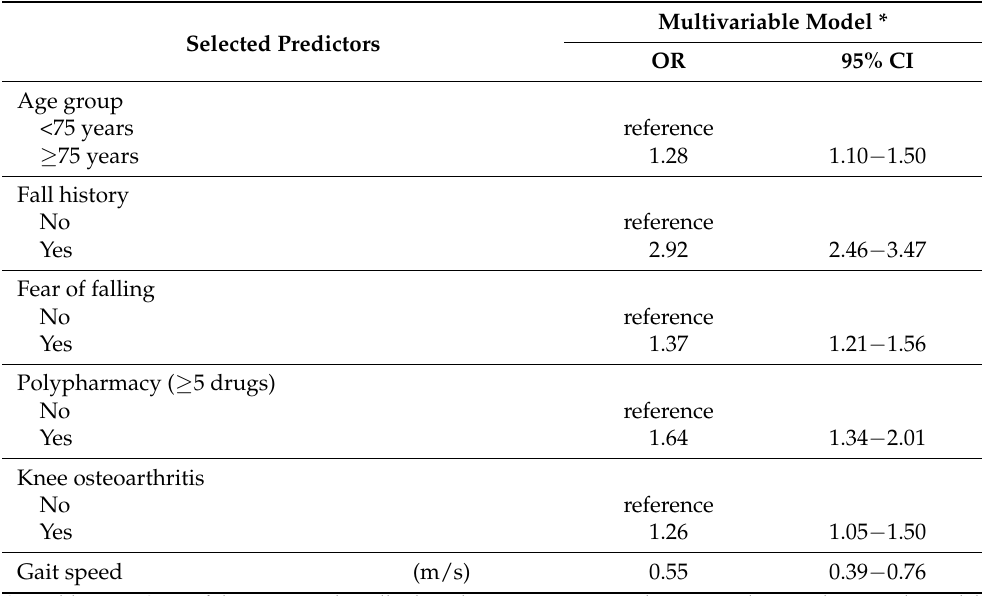
Figure 3. Stratified fall risk in the 8 terminal nodes of decision-tree model. The data are expressed as fall probabilities with 95% confidence intervals. Table 3. Backward stepwise logistic regression model to predict falls.